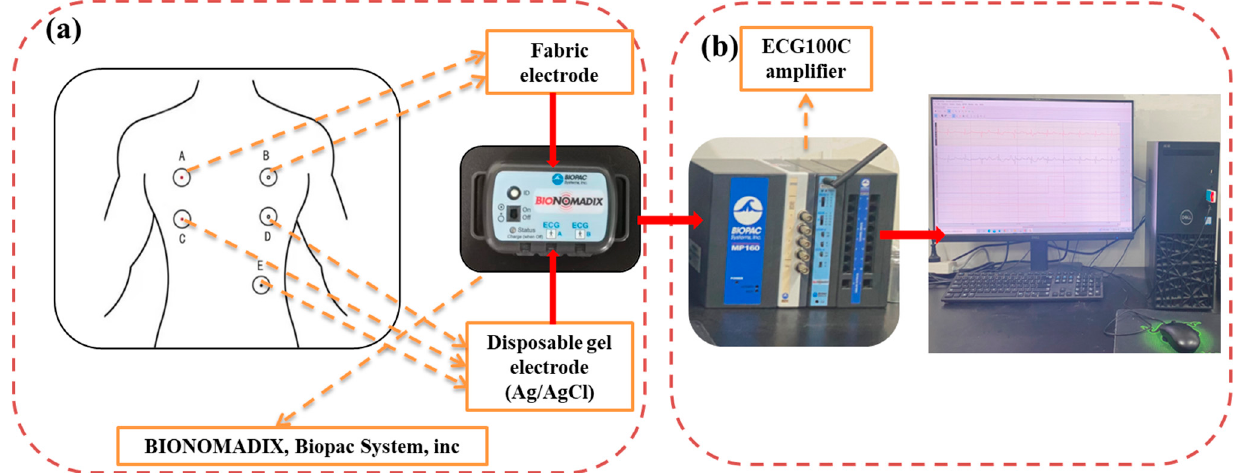
Figure 3. ( a ) Schematic diagram of human ECG test. ( b ) Diagram of ECG collection device.